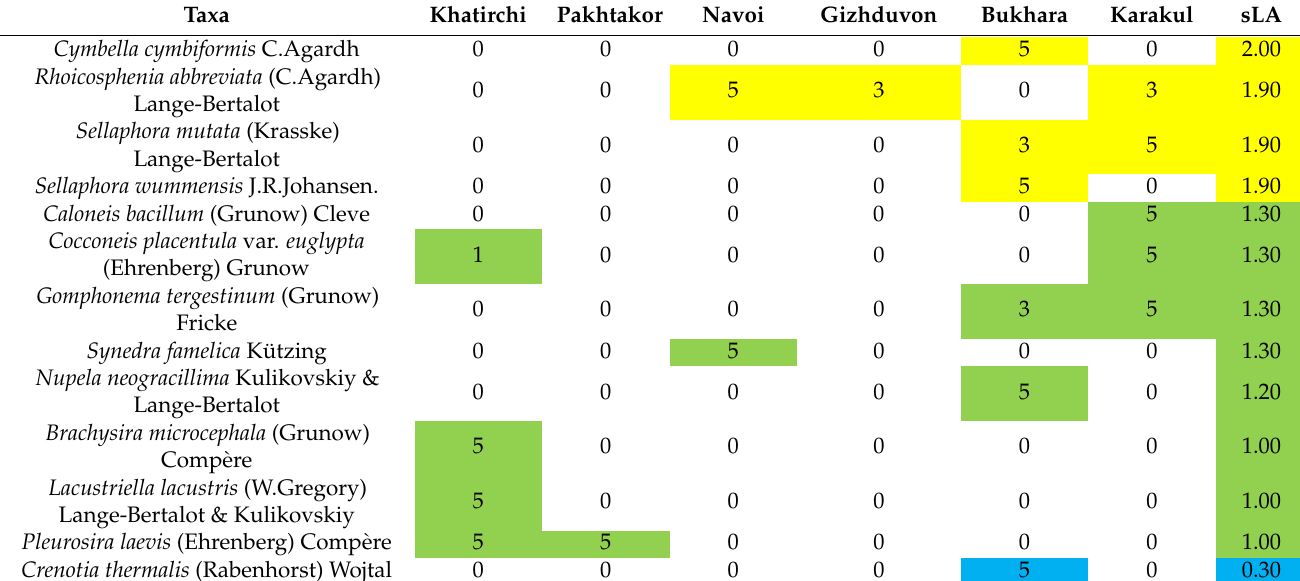
Table 4. Distribution of abundant species indicators of organic pollution according the increasing of species-specific index sLA in the Zarafshan River, 2009–2015. Abundance scores and species-specific sLA value are toned in respect of the Water Quality Class ranges (Table